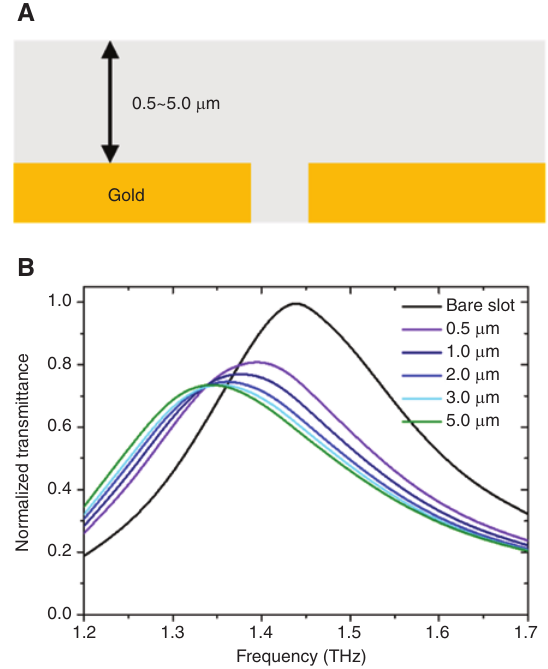
Figure 24: An interpretation of molecule interaction with nano antennas.